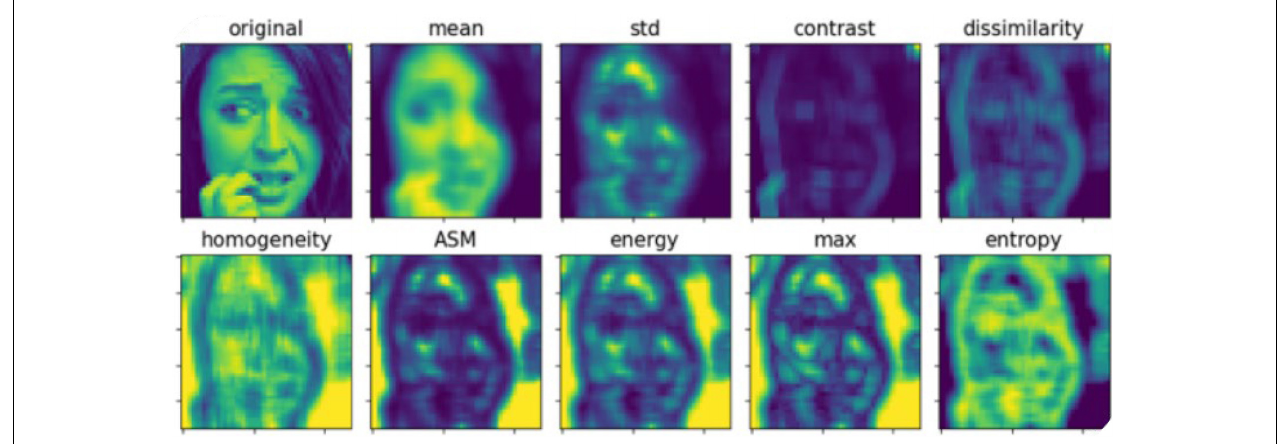
FIGURE 5 | Grayscale pseudo-color images for nine